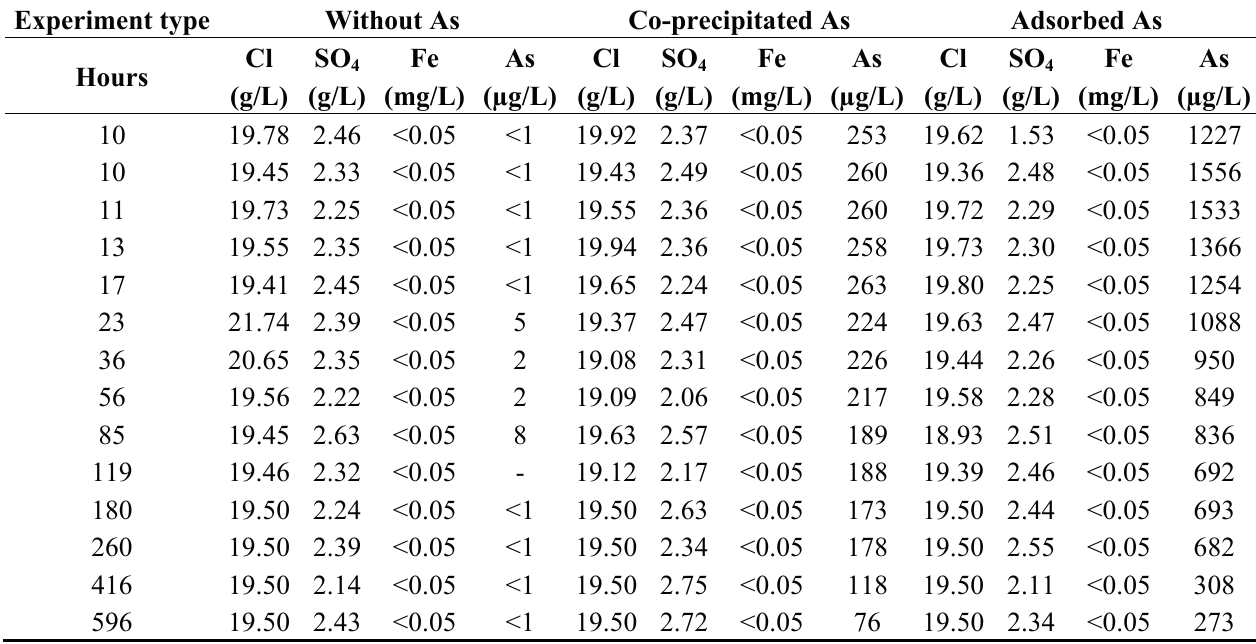
Table 3. As release from ferrihydrite.